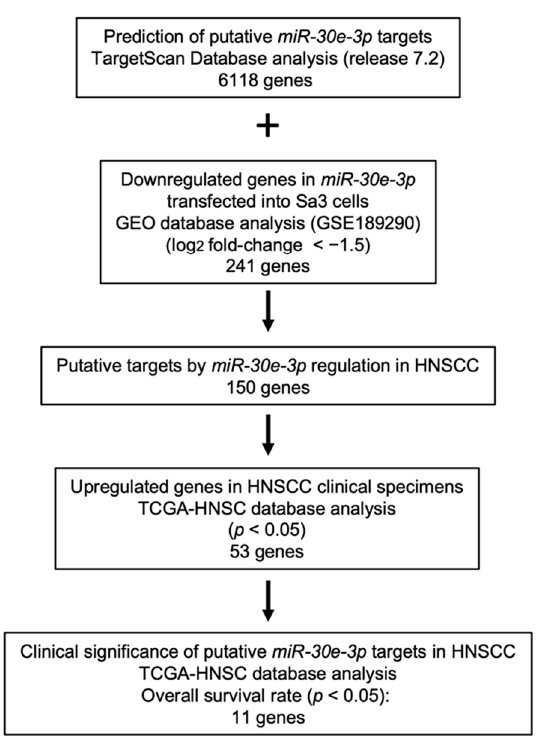
Figure 2. Flowchart of the strategy used to identify candidate miR-30e-3p target genes in HNSCC cells.